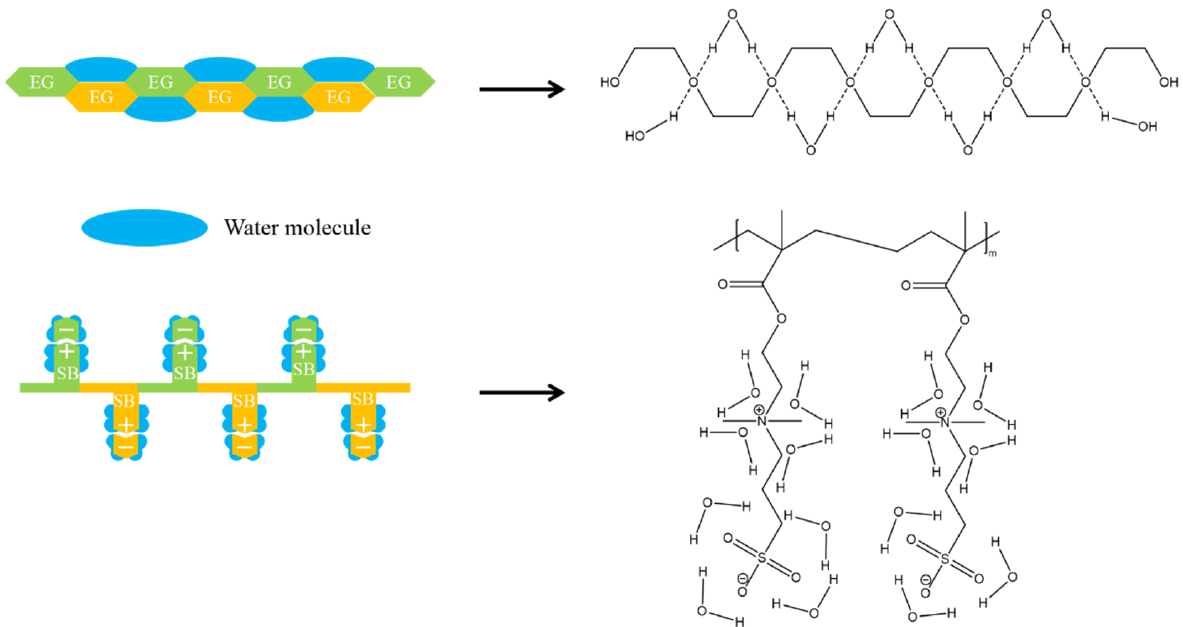
Figure 2. Tightly bonded hydration shell on zwitterionic polysulfobetaine (polySB) and PEG. Each EG unit binds 1 water molecule, while each SB unit binds 7–8 water molecules. Reproduced with permission from [17]. Copyright 2012, American Chemical Society.